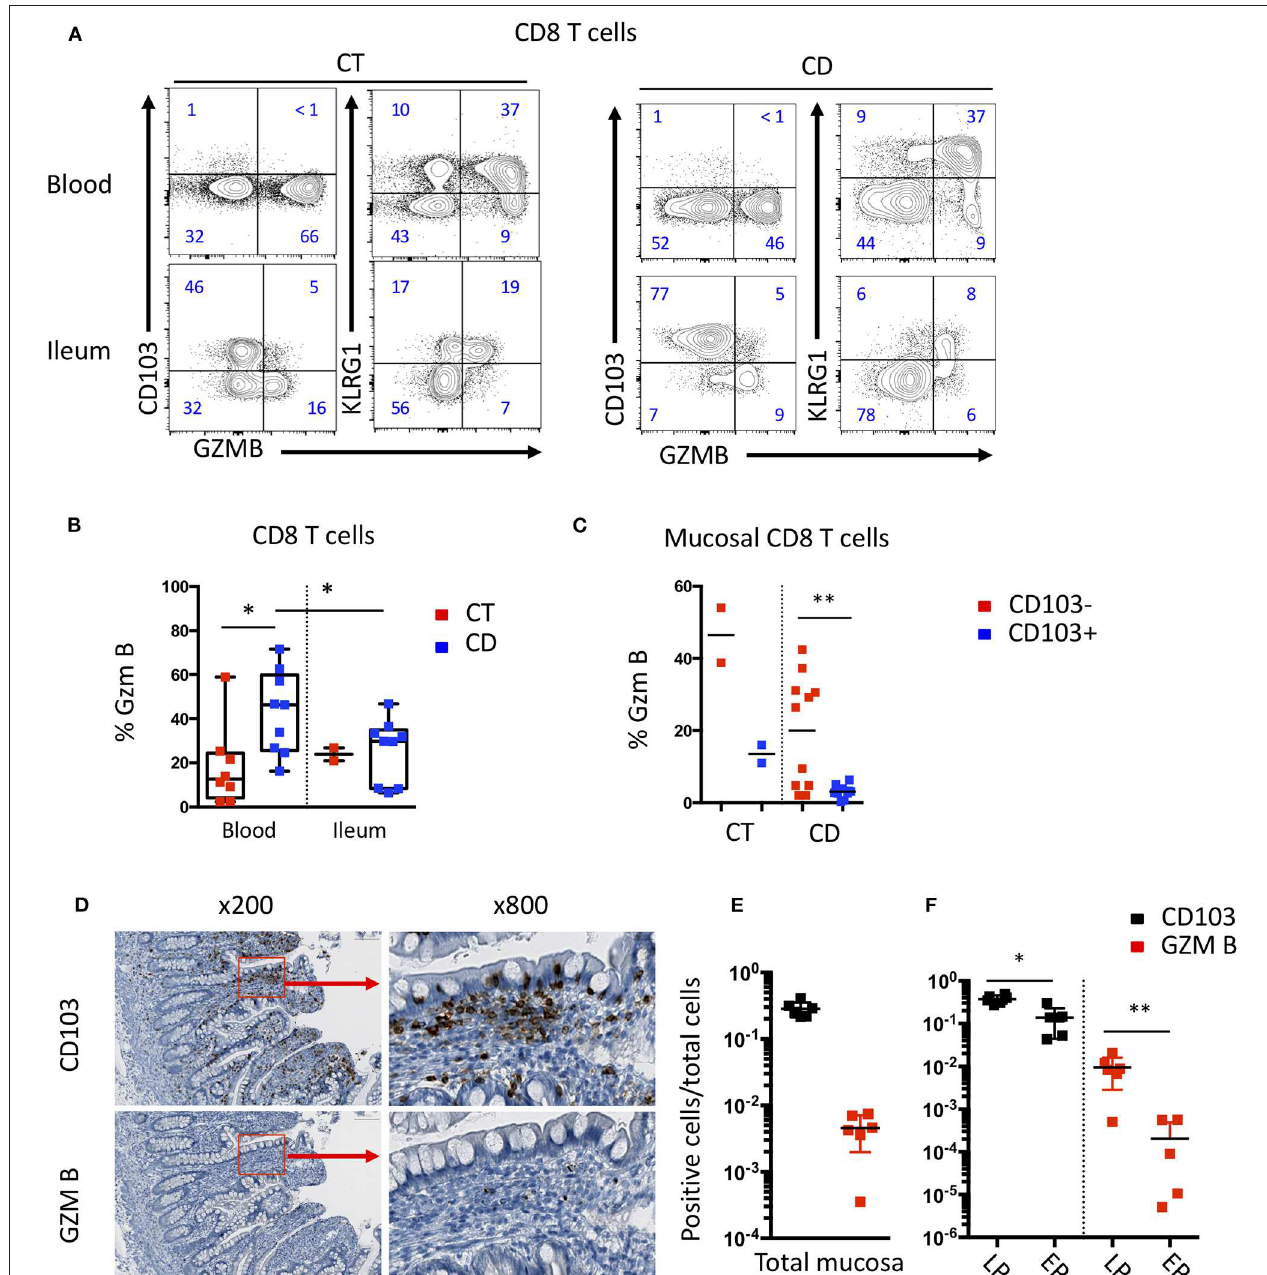
FIGURE 6 | Differential effector functions of CD103 positive and negative mucosal CD8 T cells. (A) Representative expression of CD103, KLRG1 and GZMB on CD8T cells in blood and ileal mucosa of control individuals (CT) and Crohn’s disease (CD) patients. (B) Quantification of GZMB expression on CD8T cells from blood and ileal mucosa (CT n = 2; CD n = 10; bars represent means; unpaired and paired t -test: * p < 0.05) (C) Quantification of GZMB expression on ileal CD103 + and CD103- CD8T cell subsets (CT n = 2; CD n = 10; bars represent means; paired t -test: ** p < 0.001). (D) Representative immunostaining of CD103 and GZMB on intestinal mucosa of CD patient. (E) Ratio of CD103 or GZM B positive cells on total mucosal cells ( n = 6; bars represent means; paired t -test: not significant). (F) Ratio of CD103 or GZM B positive cells on cells in the Lamina propria (LP) or epithelium (EP) ( n = 6; bars represent means; paired t -test: * p < 0.05, ** p < 0.001).